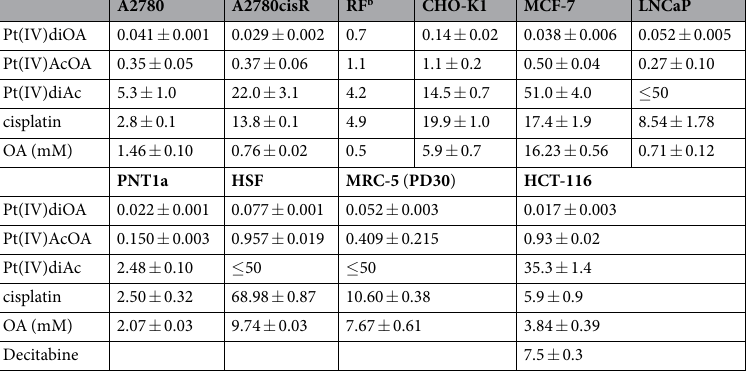
Table 1. Cytotoxicity. IC 50 mean values obtained for platinum complexes ( μ M) and octanoic acid (mM) a . a Cytotoxic effects of tested compounds were determined by MTT assay. The drug-treatment period was 72 h. The results are expressed as mean values ± SD from three independent experiments, each performed in triplicate. b RF – Resistance factor, defined as IC 50 (resistant, A2780cisR)/IC 50 (sensitive, A2780).